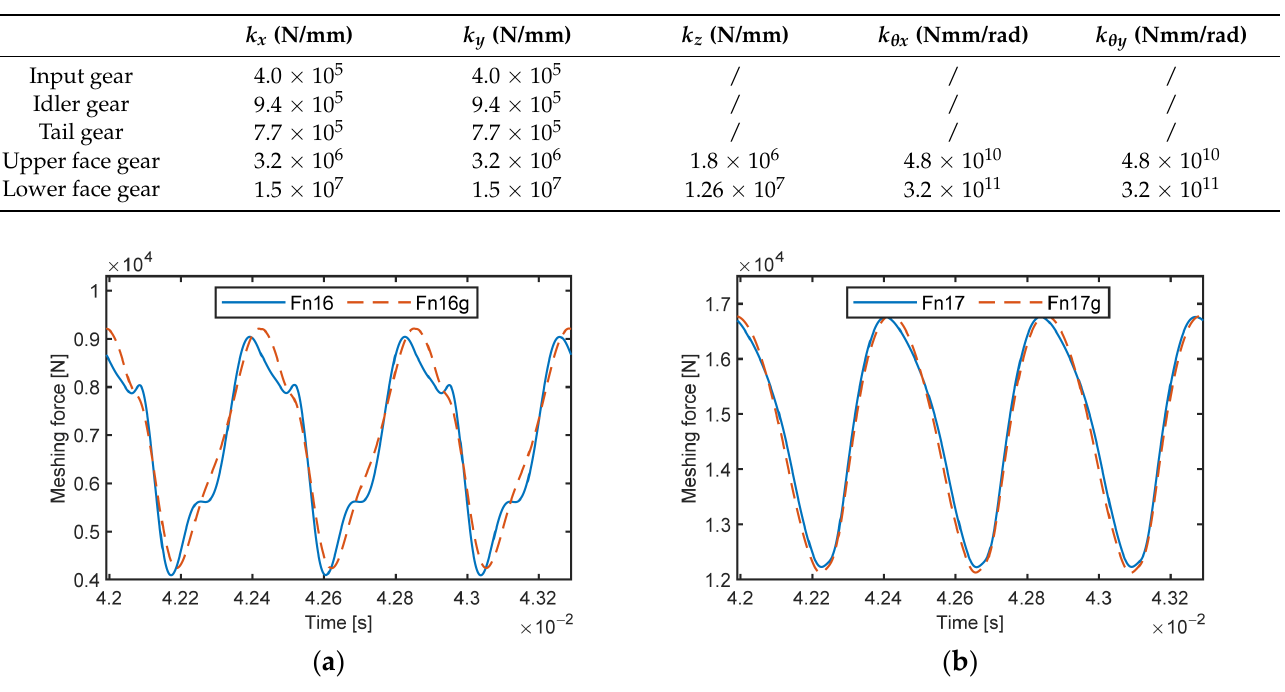
Figure 7. Di ff erence in meshing force between fi xed and varying load: ( a ) lower face gear; ( b ) upper Figure 7. Difference in meshing force between fixed and varying load: ( a ) lower face gear; ( b ) upper face gear. face gear.